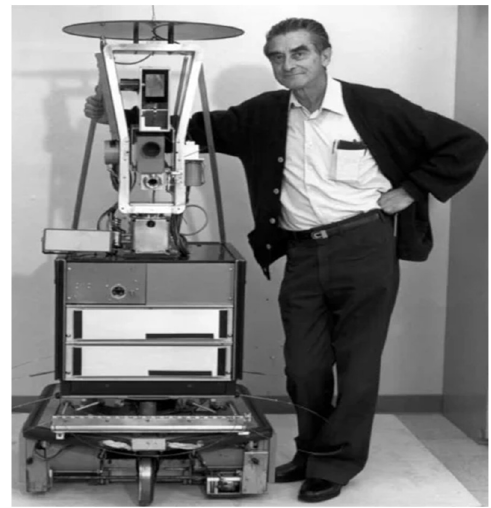
Figure 2. The robot Shakey with Charles Rosen in 1983 [7].